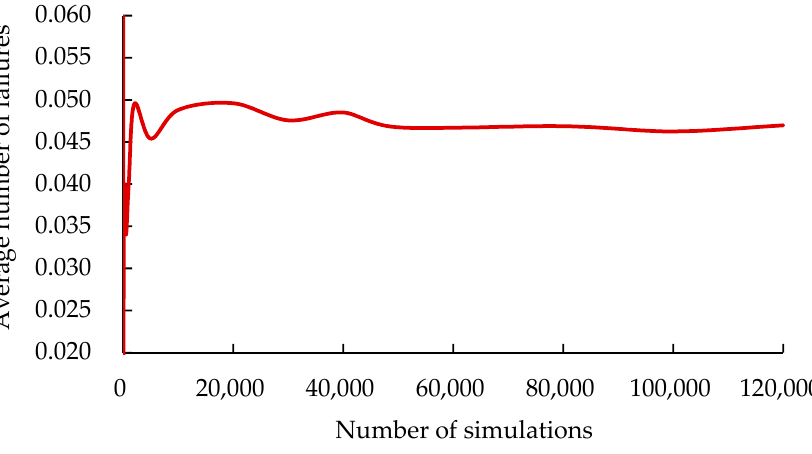
Figure 8. The average number of drivetrain failures versus the number of simulations.